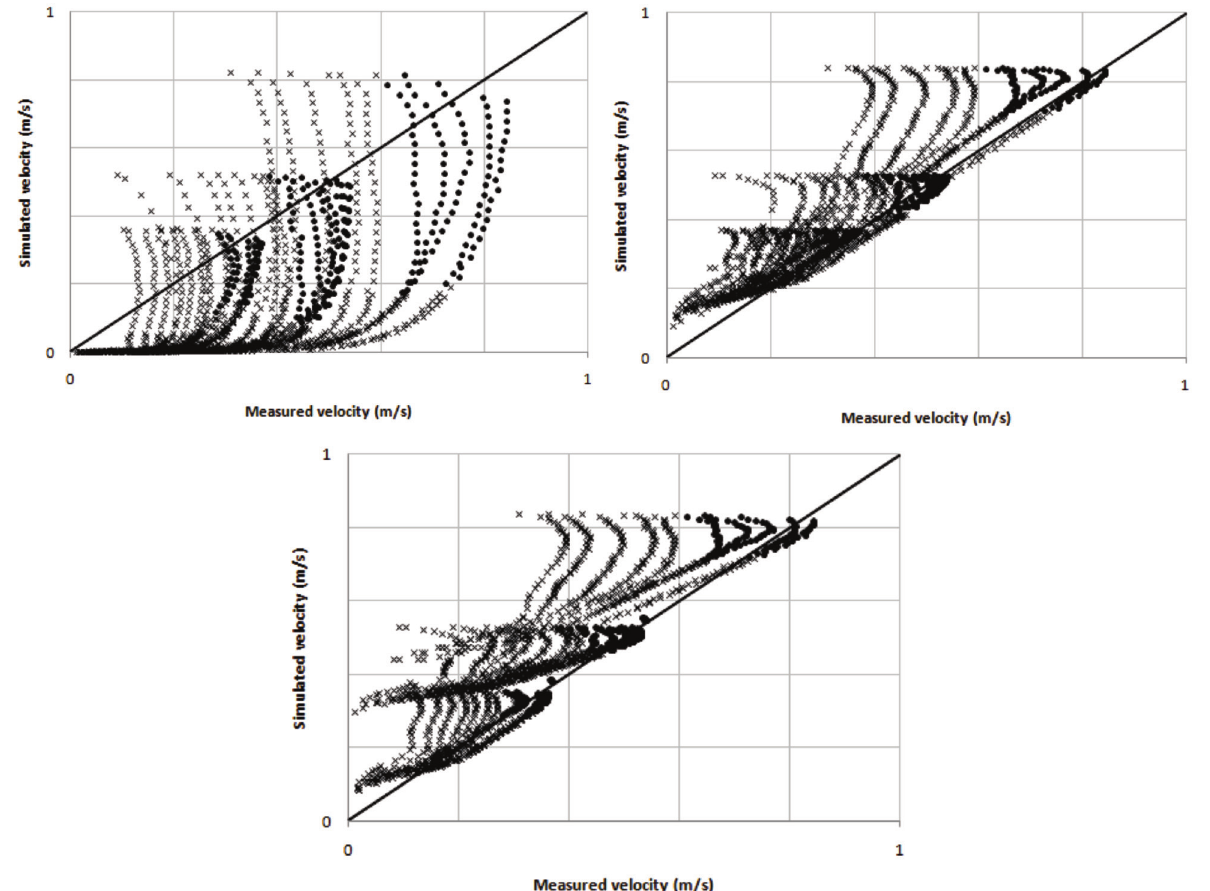
Figure 2. Correlation between measured (experiments SRP1, SRP2, and SRP3: Steffler et al. 1985) and simulated velocities using the weak statement (Cartesian coordinates): (a) model U1y; (b) model U2y; and (c) model U3y. The black dots represent points located further than 3% of the channel width from the sidewalls and from the channel bed, whereas the plus (+) signs refer to the points located elsewhere (near wall and/or channel